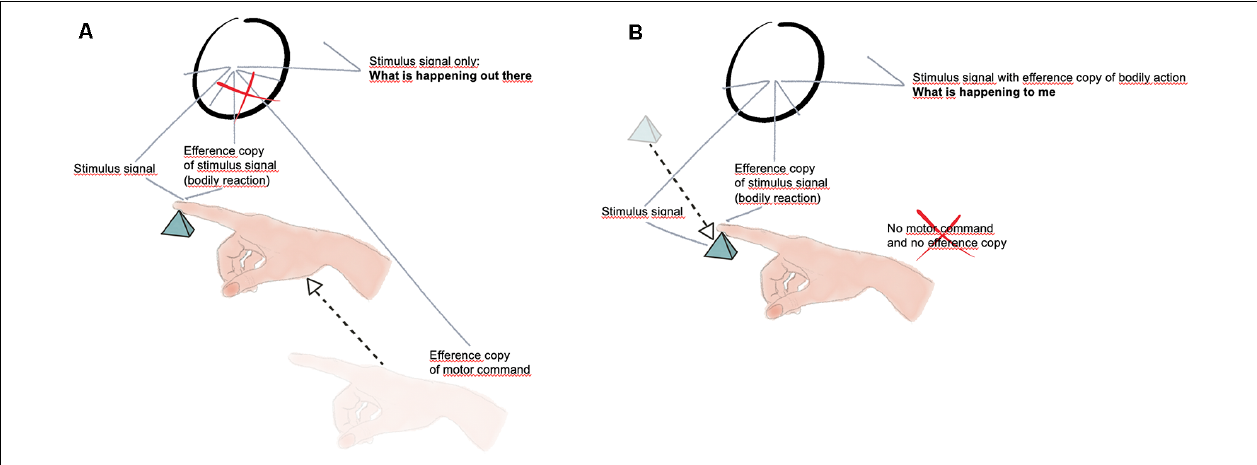
FIGURE 1 | (A) The movement of the hand is associated with an efference copy that annihilates the efference copy associated with the local bodily reaction, thus giving rise to the perception of an object out there without sensation (Drawing by Elena Lorenzi). (B) The object is moving and hits the finger; in the absence of active hand movement there is no efference copy to annihilate the efference copy associated with the local bodily reaction, thus a sensation (what is happening to me) arises (Drawing by Elena